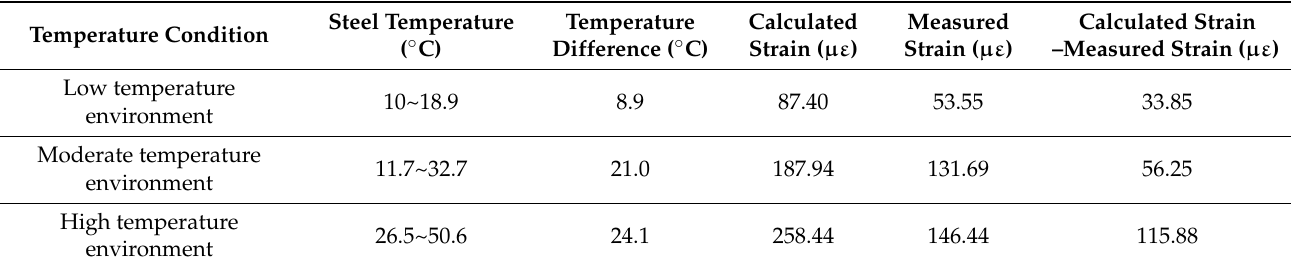
Figure 16. Influence of typical ambient temperature change on steel brace strain. Table 3. Strain of steel brace at different ambient temperatures.